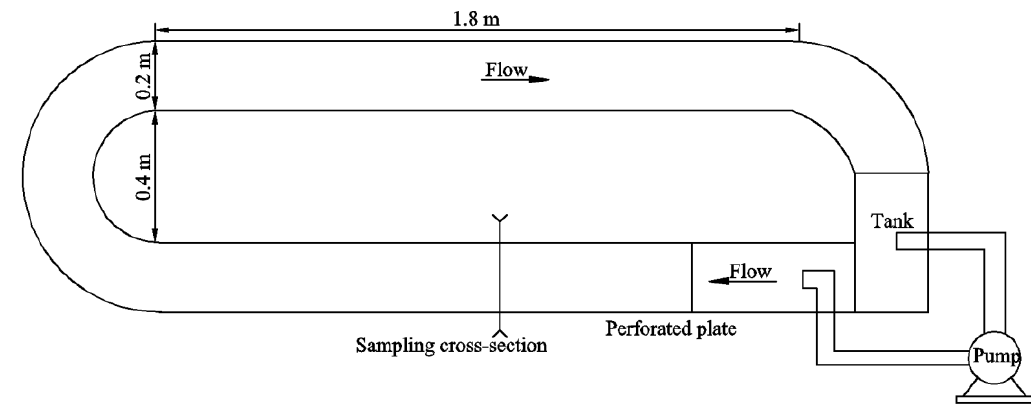
Figure 1. Sketch of the experimental apparatus.